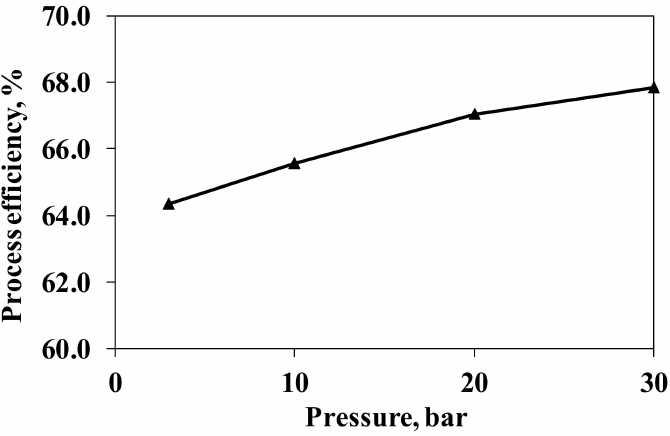
Figure 11. Influence of pressure on overall process efficiency for a 5000 kg/h PEFB plant operating at 3, 10, 20 and 30